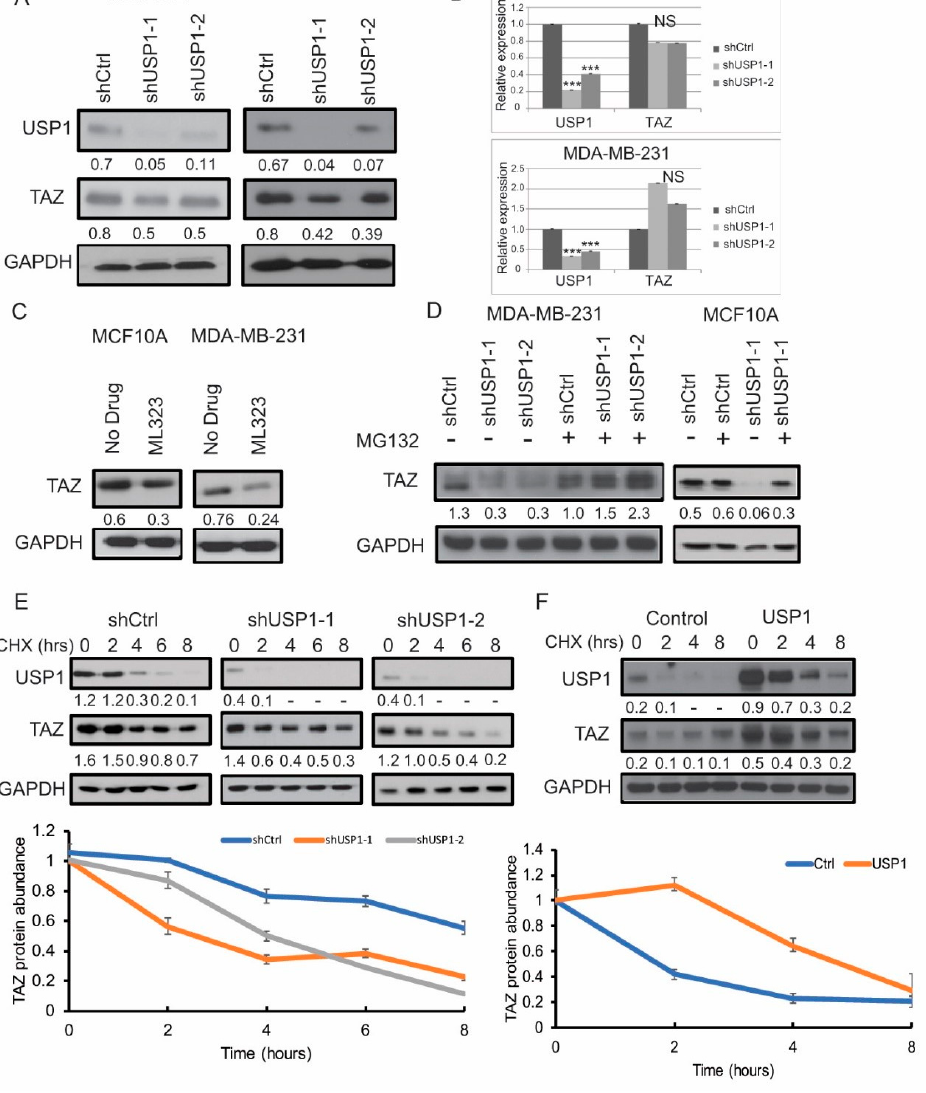
Figure 2. USP1 acts as a post-translational modifier of TAZ. ( A ) Immunoblot analysis for USP1 and TAZ expression in USP1 knockdown MCF10A and MDA-MB-231 cells. GAPDH was used as a